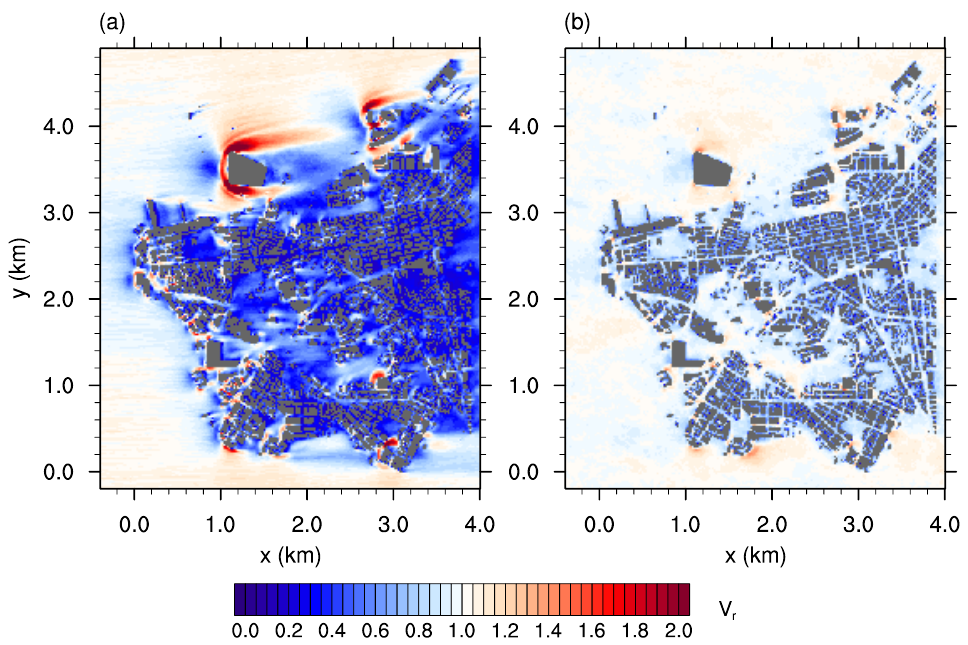
Figure 5. Velocity ratio V r for the ( a ) neutral case and ( b ) unstable